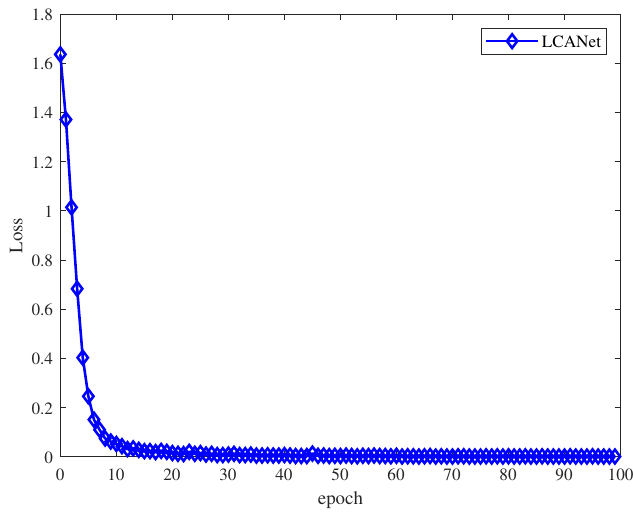
Figure 9. Training loss of